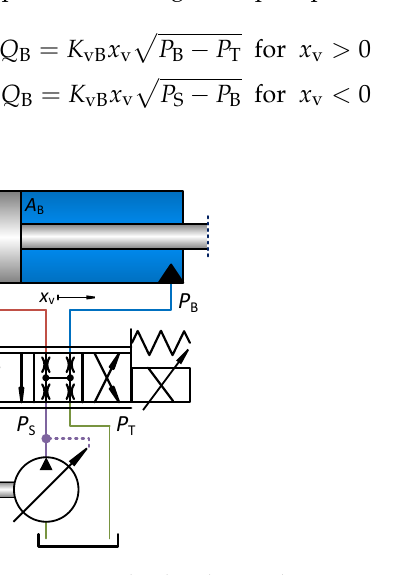
Figure 6. Schematics of a conventional valve drive